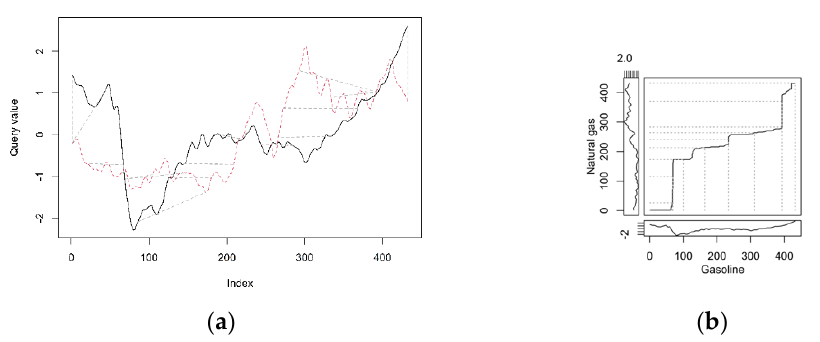
Figure 6. Alignment plots for gasoline and natural gas for the full period. ( a ) Two-way, ( b ) Three-way. On the two-way plot the black solid line for gasoline, the red dashed line for natural gas. Source: own elaboration on the basis of data from www.stooq.com (accessed on 19 April 2021).